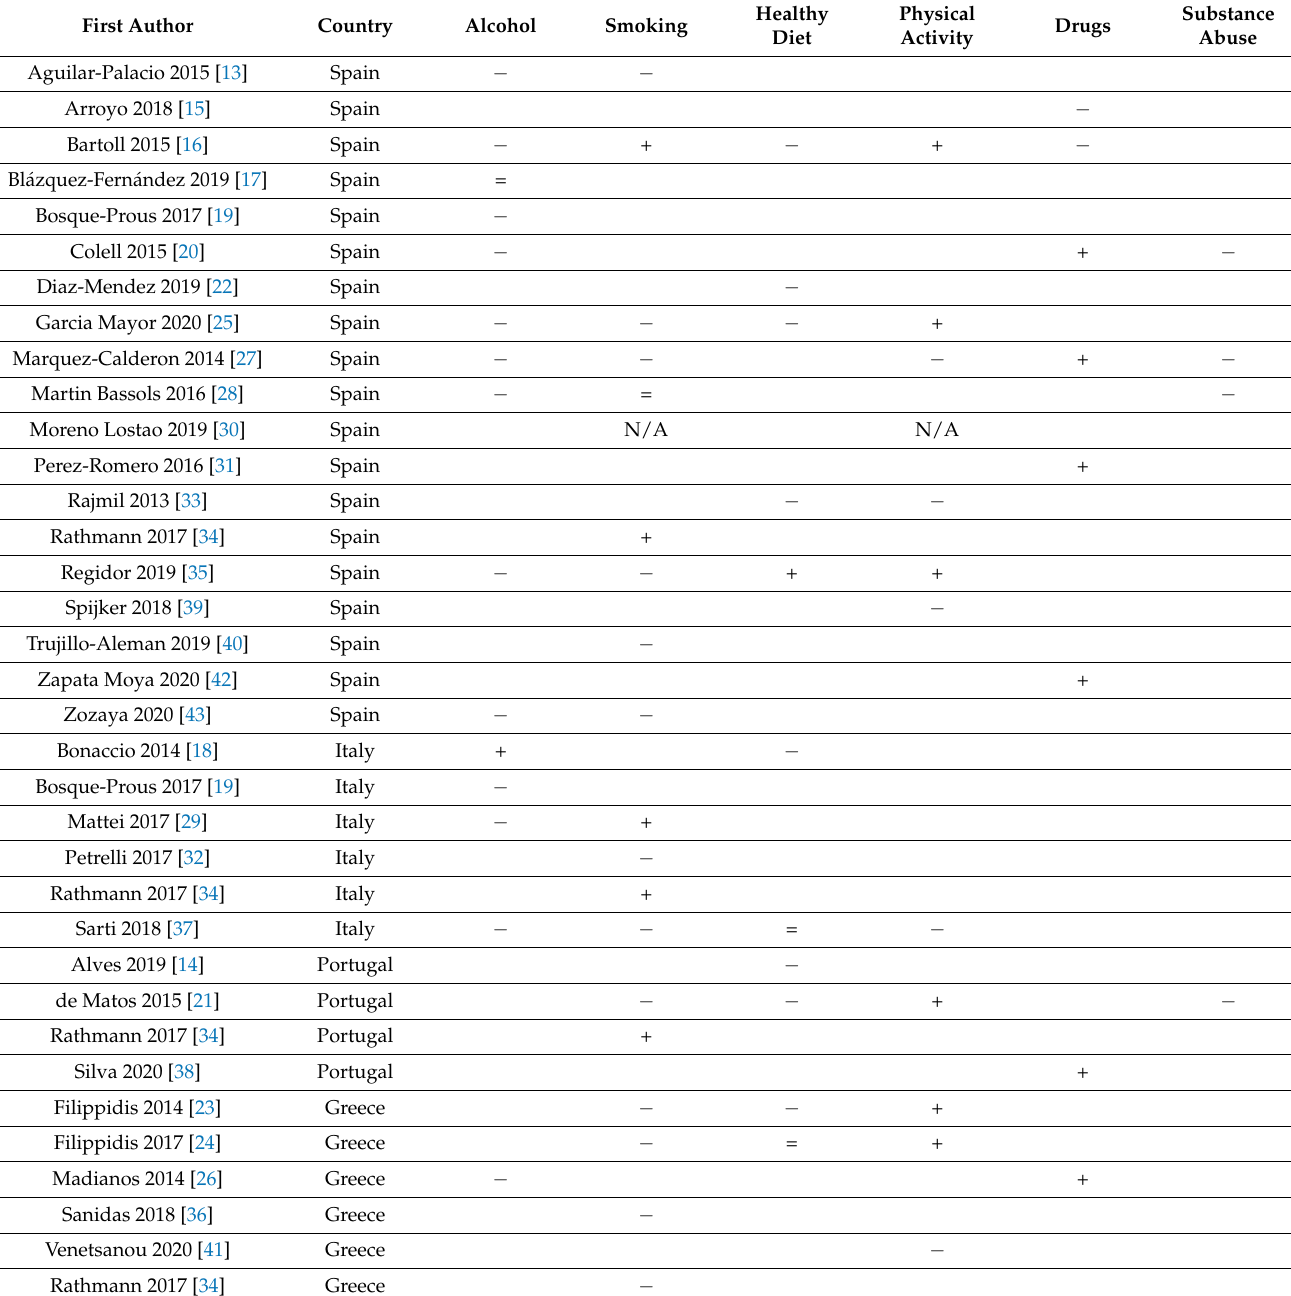
Table 2. Variation of behavior influencing health status during or after the 2008 financial